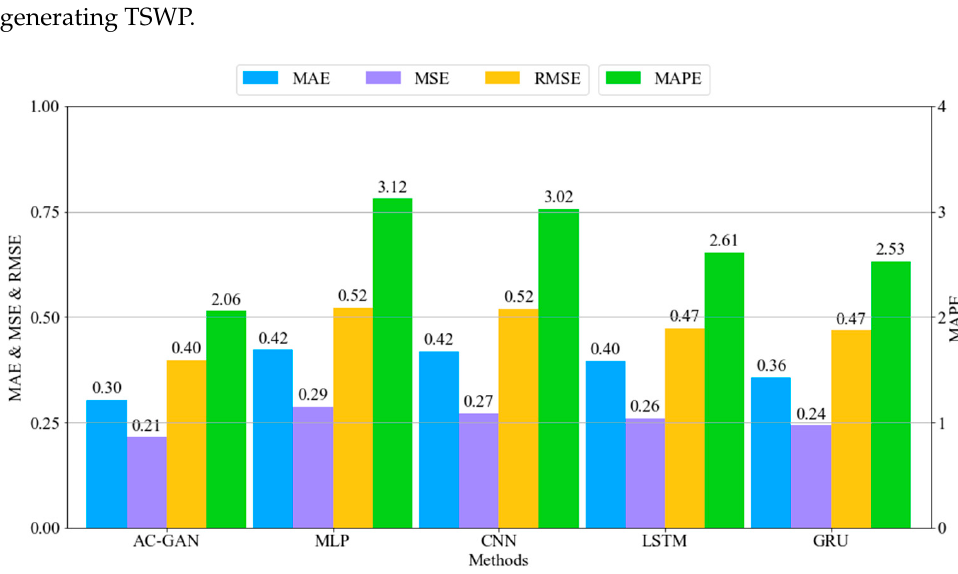
Figure 12. Error rates of melting process models.